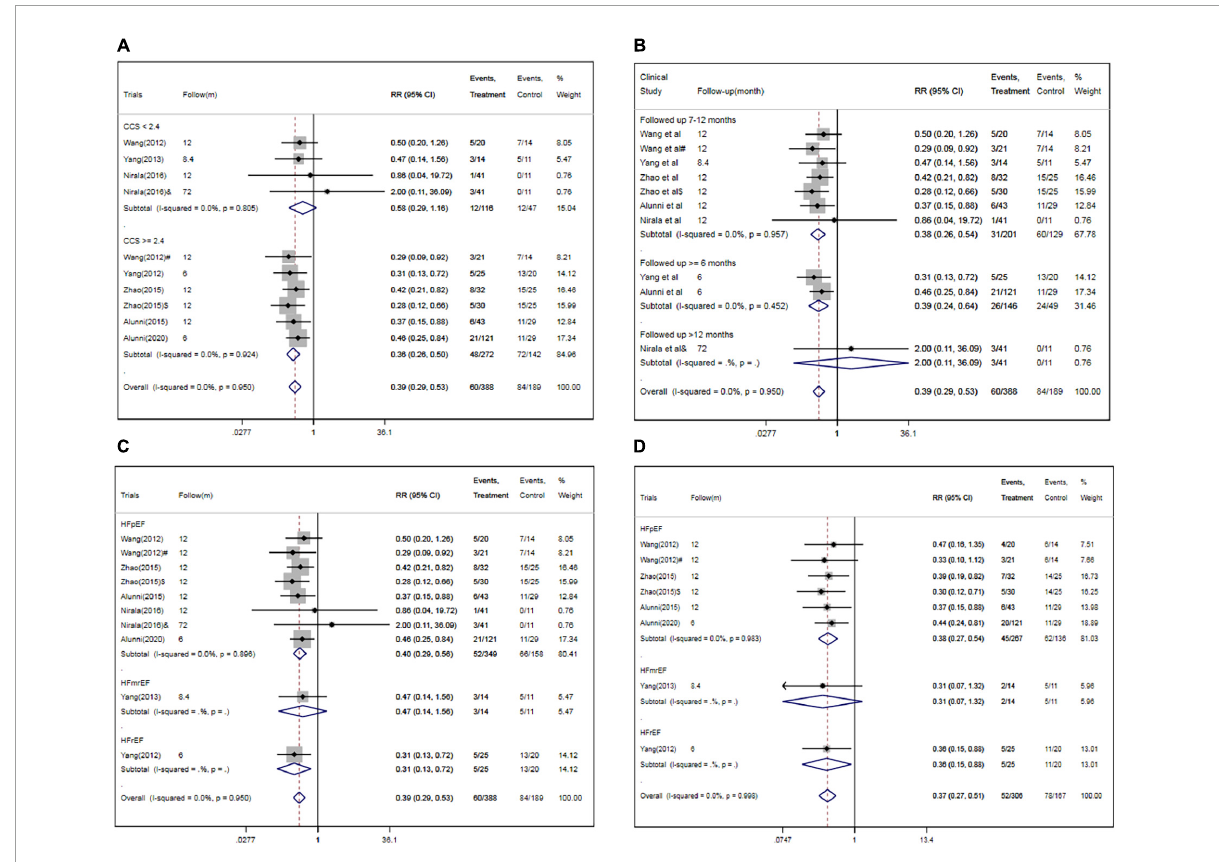
FIGURE7 Subgroup analysis for MACEs and/or rehospitalization in studies specified by baseline CCS angina class (A) , follow-up period (B) , HF classification (C,D) . CSWT, cardiac shock wave therapy; MACE, major adverse cardiac event; RR, relative risk; CI, confidence interval; CCS, Canadian Cardiology Society. # Patients treated with short-term regimen of CSWT; $ , patients treated with an expanding scope CSWT; and & , patients with long-term